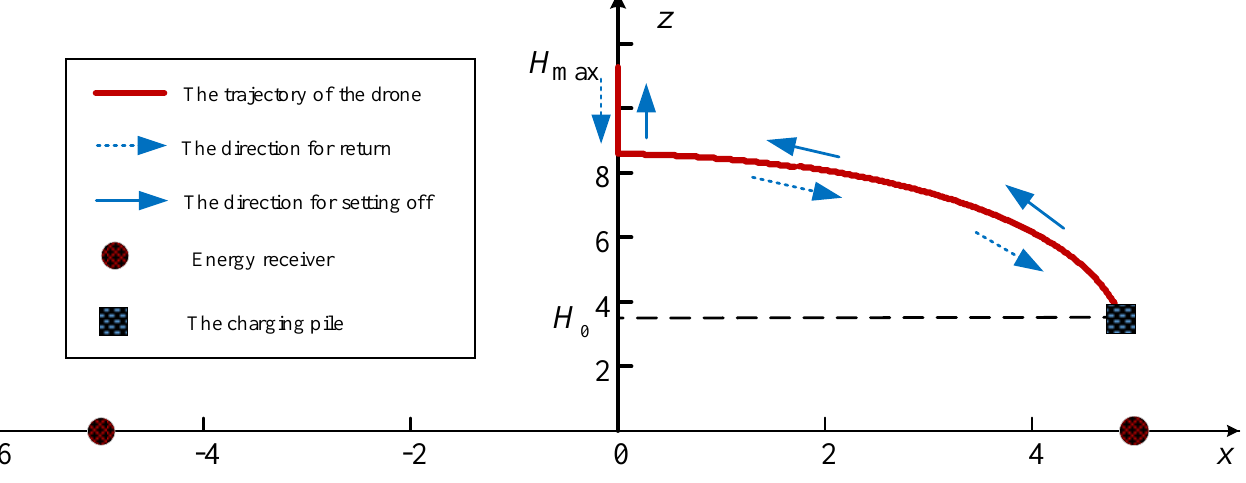
Figure 2. The trajectory design for a two-user WPT